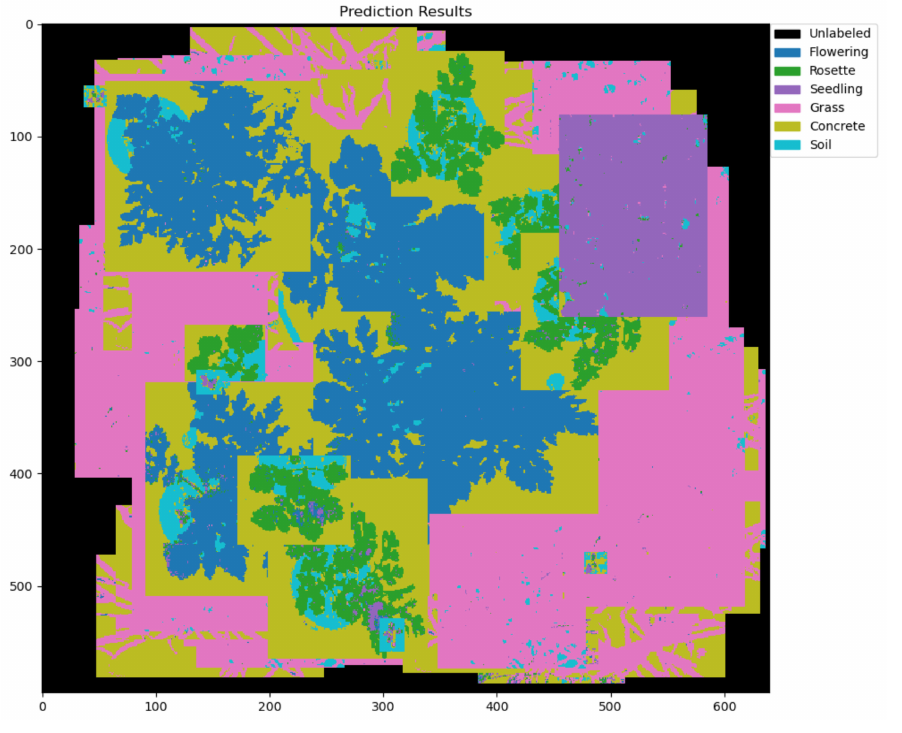
Figure 12. Output of combined hypercube with predicted colour